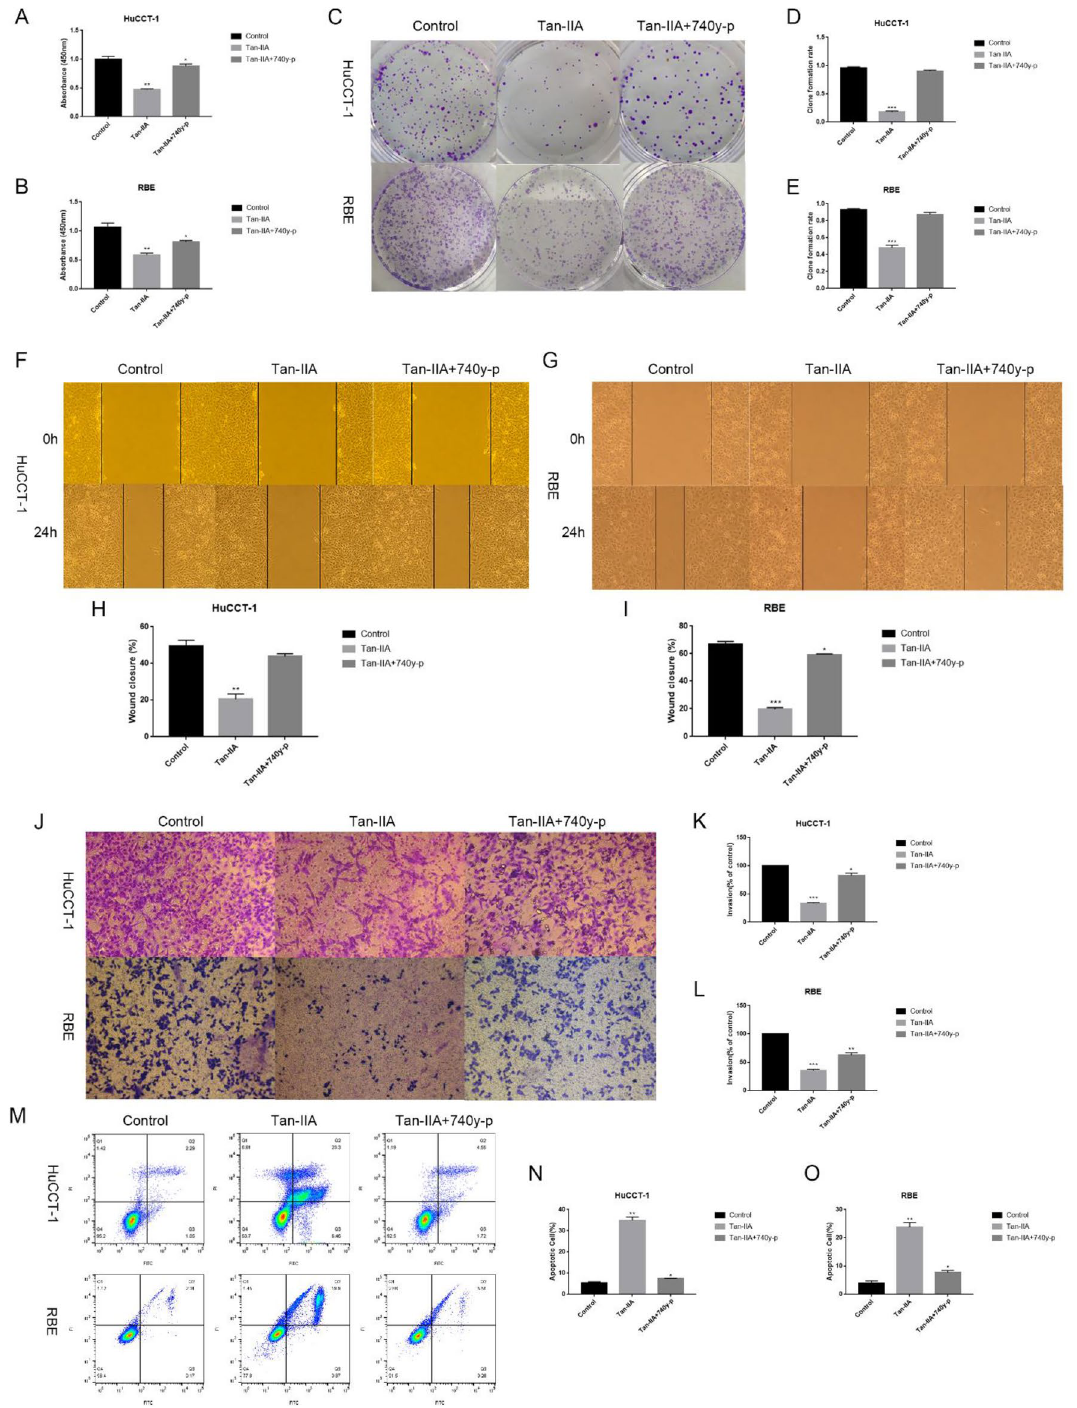
Figure 4. PI3K agonists attenuate the tumor suppressive effect of Tan-IIA. After the addition of 740y-p (10 µg /mL) to the system in which Tan-IIA (24 h IC50 concentration) and Cholangiocarcinoma cells were co-cultured, the tumor suppressive effect of Tan-IIA was attenuated. ( A – E ) The inhibitory effect of Tan-IIA on the proliferation of Cholangiocarcinoma cells decreased after the addition of 740y-p. ( F – L ) The ability of Tan- IIA to inhibit the invasion and migration of Cholangiocarcinoma cells was reduced after the addition of 740y-p. ( M – O ) The apoptosis-inducing effect of Tan-IIA on Cholangiocarcinoma cells was diminished after 740y-p was added. Compared with control, * p < 0.05; ** p < 0.01; *** p <